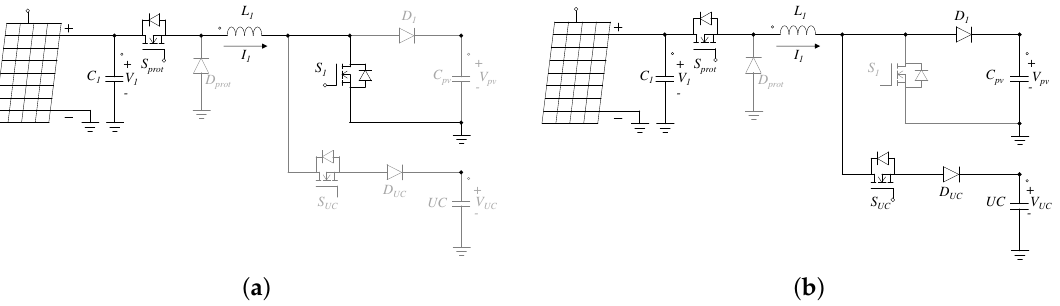
Figure 7. Operating modes of the converter associated with the PV when V UC > V 1 , ( a ) charge of the inductor, ( b ) discharge of the inductor.